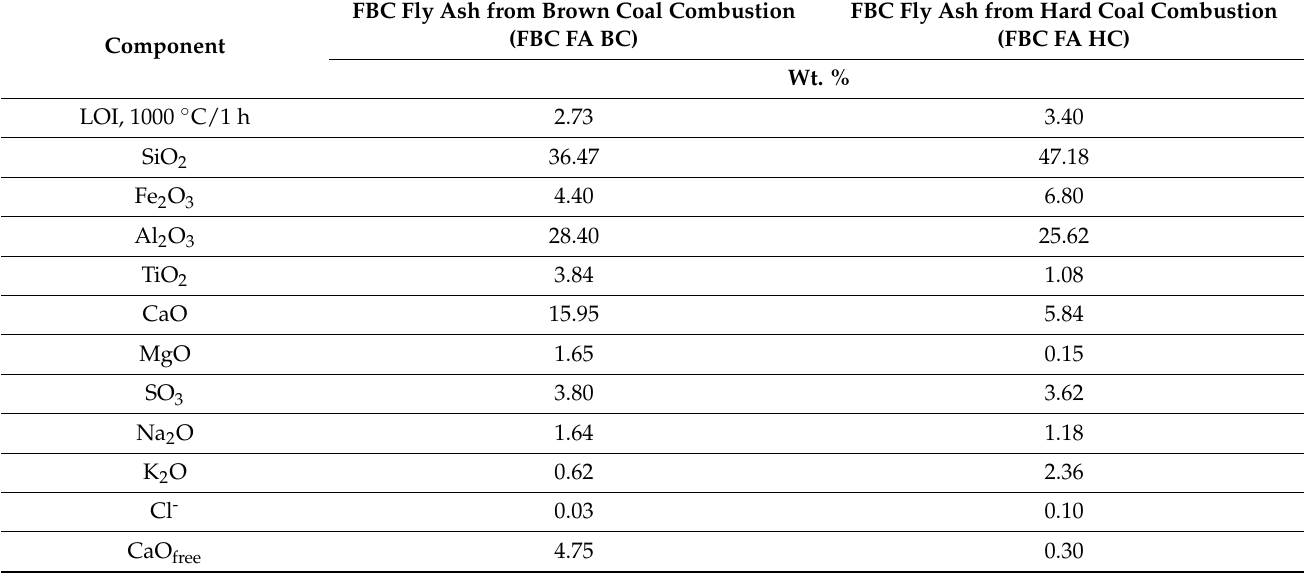
Table 1. The chemical composition made according to EN 196-2 procedures of the two types of FBC fly ash obtained from brown and hard coal combustion.